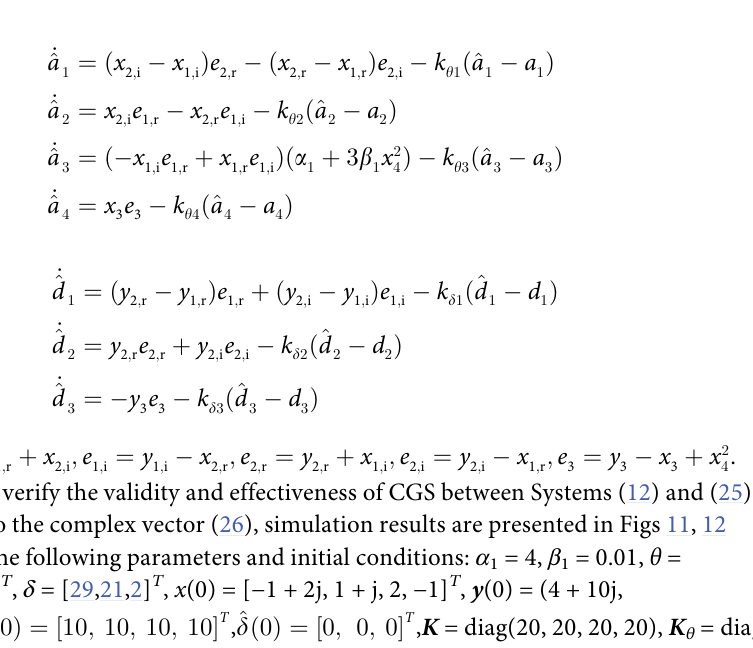
Fig 11. CGS process of systems (12) and (25) with respect to the given complex map vector (cid:2) ð x Þ ¼ ½ j x 2 ; j x 1 ; x 3 (cid:3) x 2 4 (cid:4) T . (a) x 2,i , y 1,r ; (b) x 2r , y 1,i ; (c) x 1,i , y x y x x 2 ; y 3 (cid:3) 3 . 2,r ; (d) 1,r , 2,i ; (e) 4